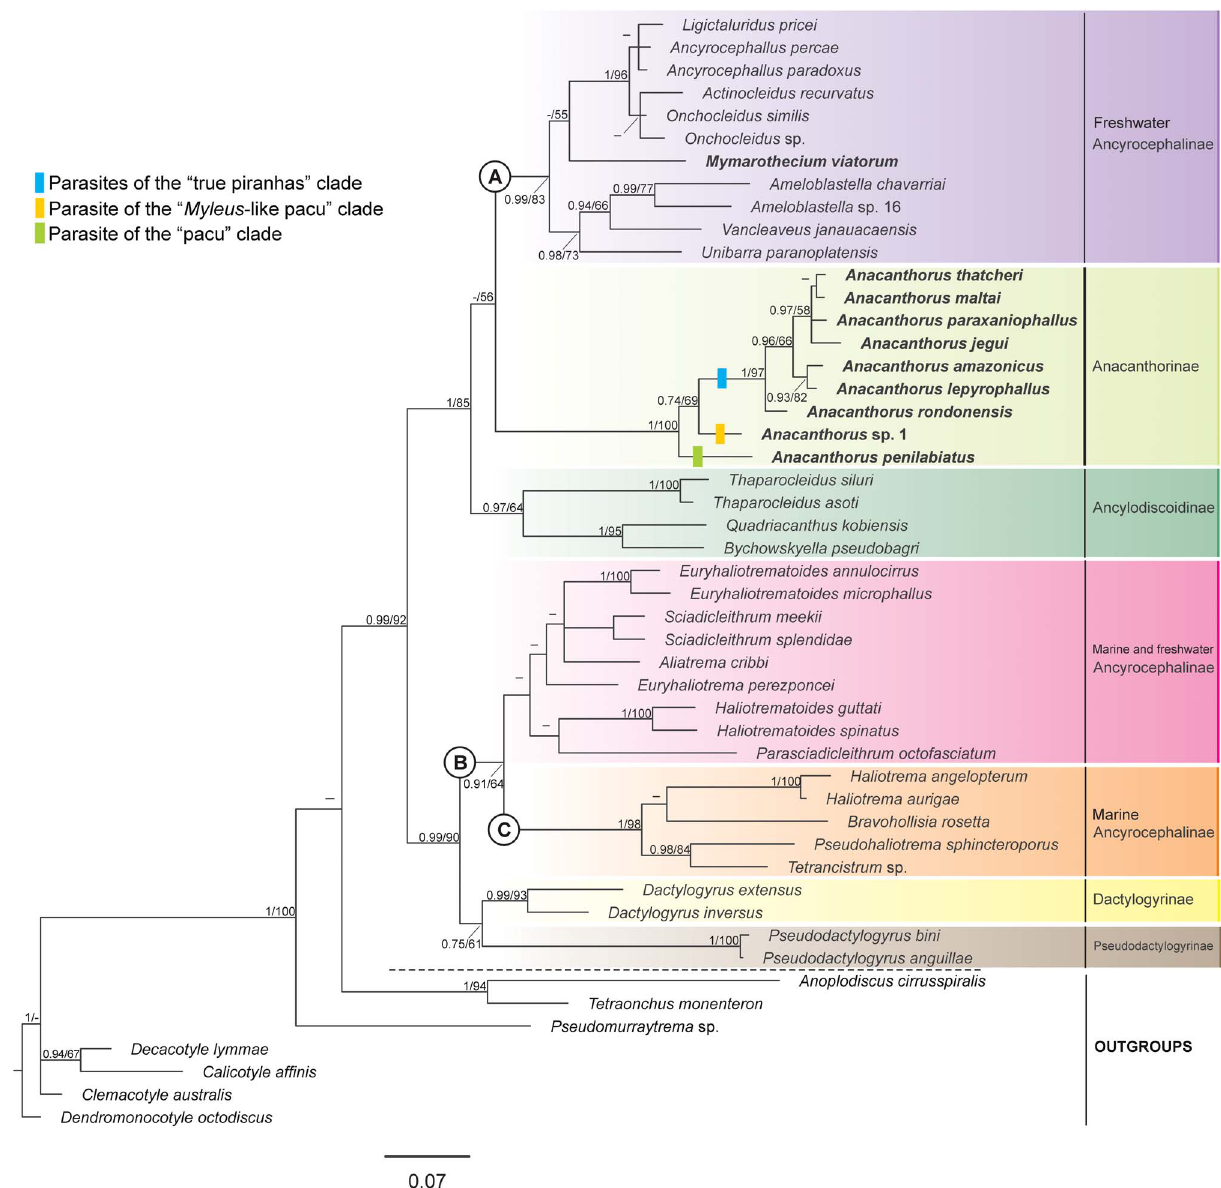
Figure 1. Consensus Bayesian topology from the phylogenetic analysis of partial 28S rDNA of 49 species of monogeneans. BI posterior probabilities and ML bootstrap values are shown at the nodes. Posterior probabilities <0.7 are not reported. Bootstrap values <50 are not reported. Species sequenced in the present study are shown in